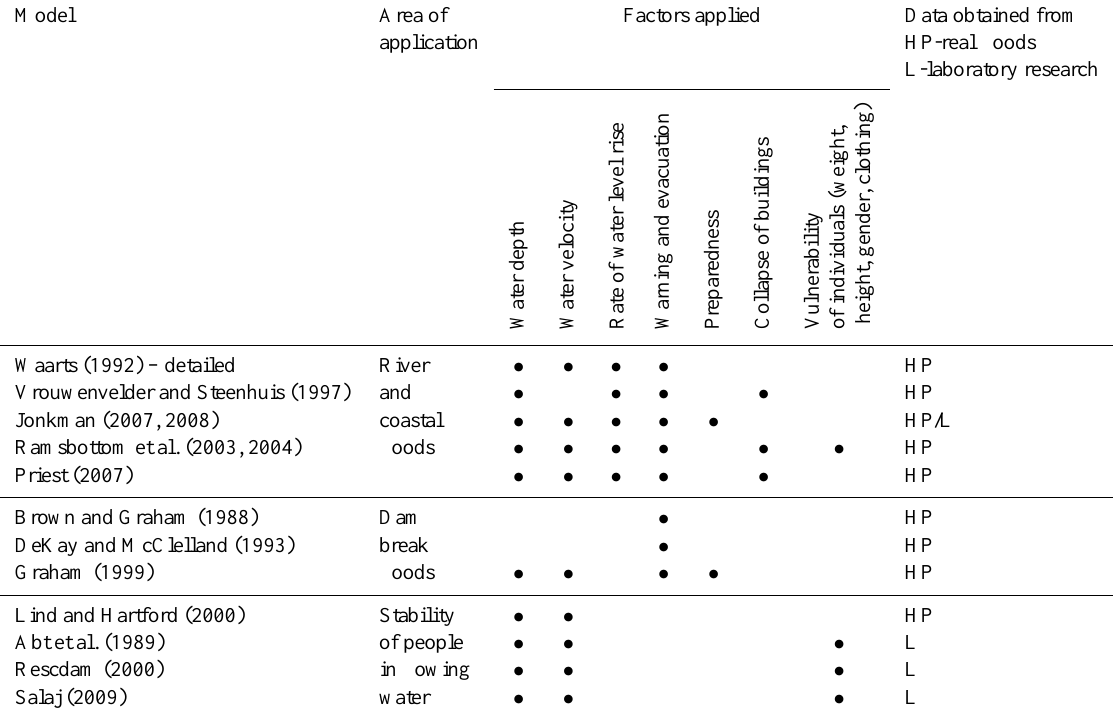
Table 1. Overview of the selected models developed for the estimation of loss of life due to different kinds of floods.